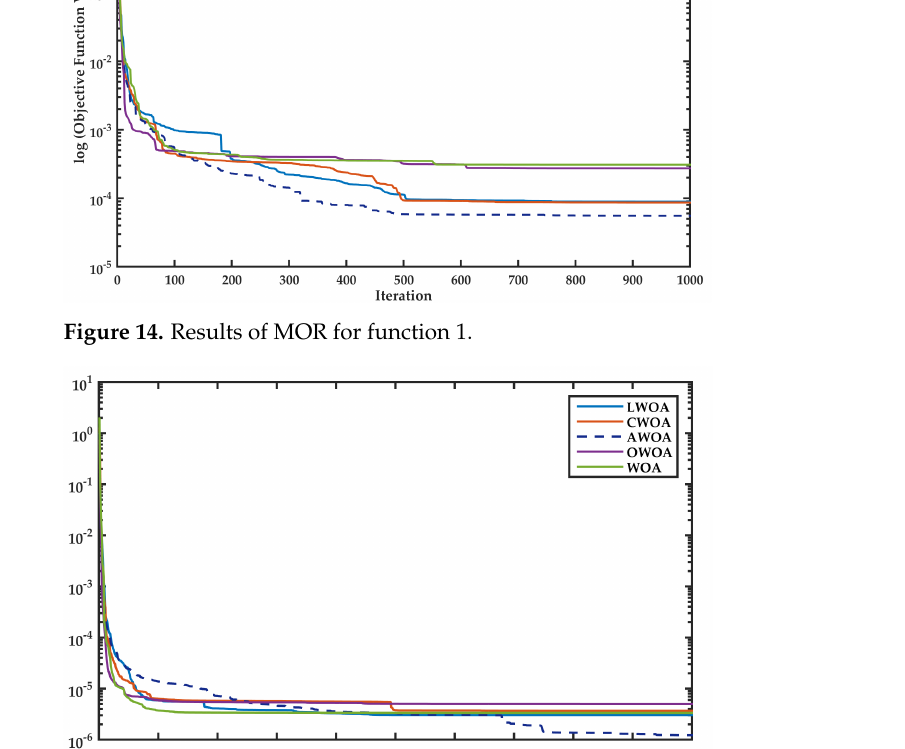
Figure 15. Results of MOR for function